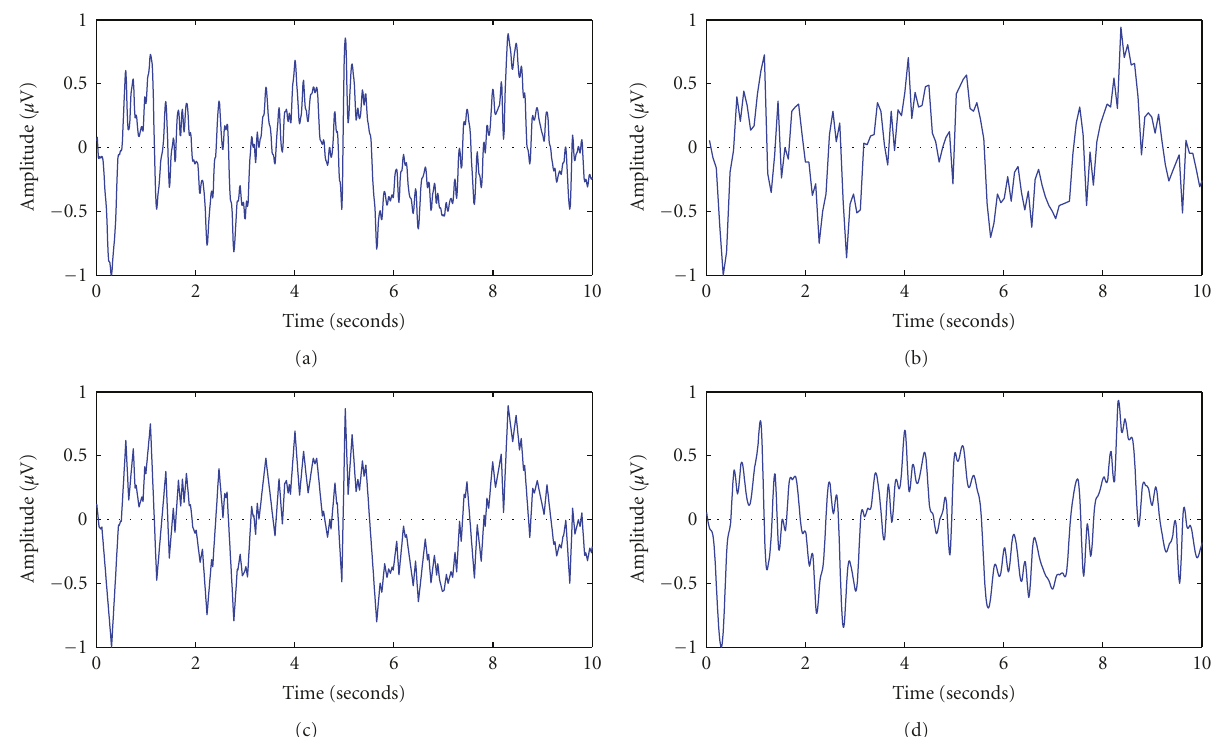
Figure 11: Comparison of reconstruction of an EEG signal acquired by our method. (a) The original signal sampled at 256 Hz. (b) The EEG signal acquired by our method at 47 . 5 Hz with 2 K = 474 . (c) The reconstructed EEG signal at 256Hz with our method CC = 97 . 08%, RMSE = 0 . 0099, PRD = 22 . 43%, MAXERR = 0 . 0016. (d) The reconstructed EEG signal using the traditional sinc interpolation method CC = 90 . 11%, RMSE = 0 . 0147, PRD = 48 . 30%, MAXERR = 0 .